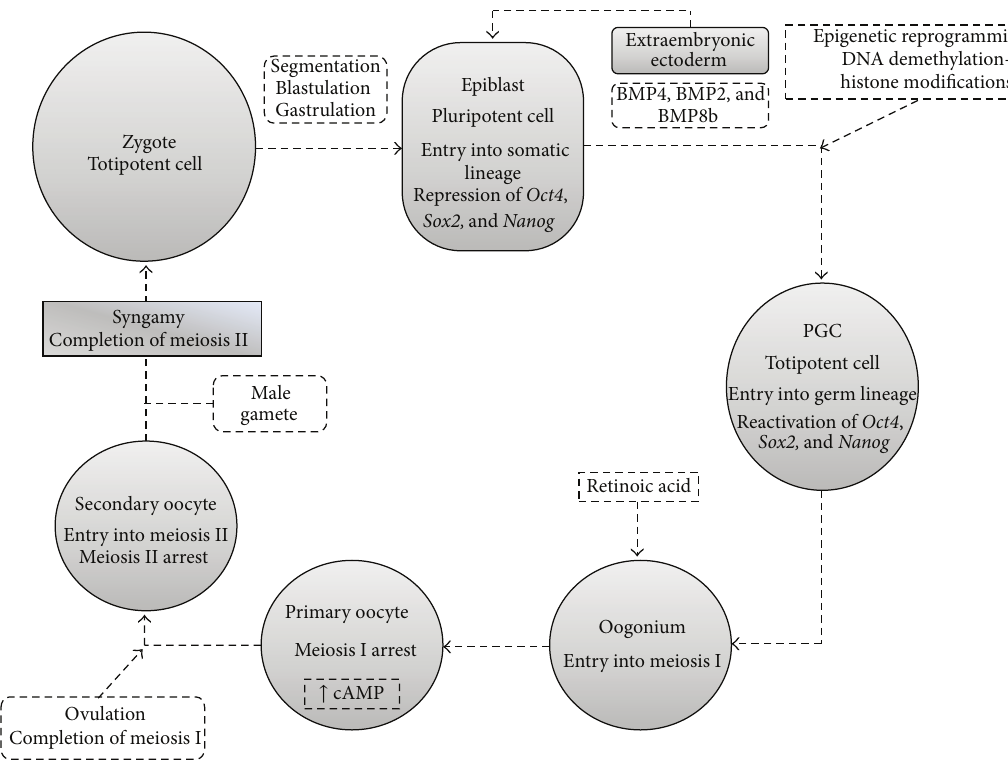
Figure 3: Cellular stages and signaling in female germ cell development. Syngamy produces a single totipotent cell, the zygote, which evolves through various structural stages. After gastrulation, extraembryonic ectoderm induces some epiblastic cells into pluripotency and entry into somatic lineage. These later undergo epigenetic reprogramming to regain totipotentiality and become primordial germ cells. These migrate to the gonadal ridges and suffer intense mitosis, becoming oogonia, which are then induced by retinoic acid to enter meiosis I. Primary oocytes are then arrested in this division and appear to survive until ovulation due to elevated intracellular cAMP levels. With ovulation, meiosis I is completed and meiosis II begins in secondary oocytes. Nonetheless, this division is only fulfilled if union with a male gamete occurs, which ultimately leads to formation of a